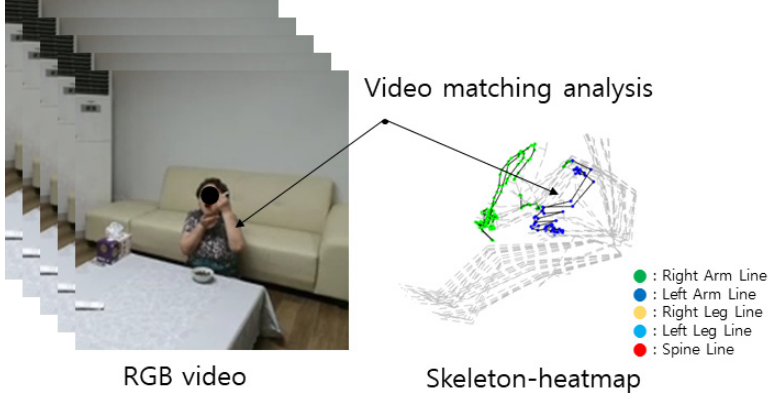
Figure 6. Video matching analysis of the skeleton-heatmap for the behavior of an elderly person eating food with a spoon.